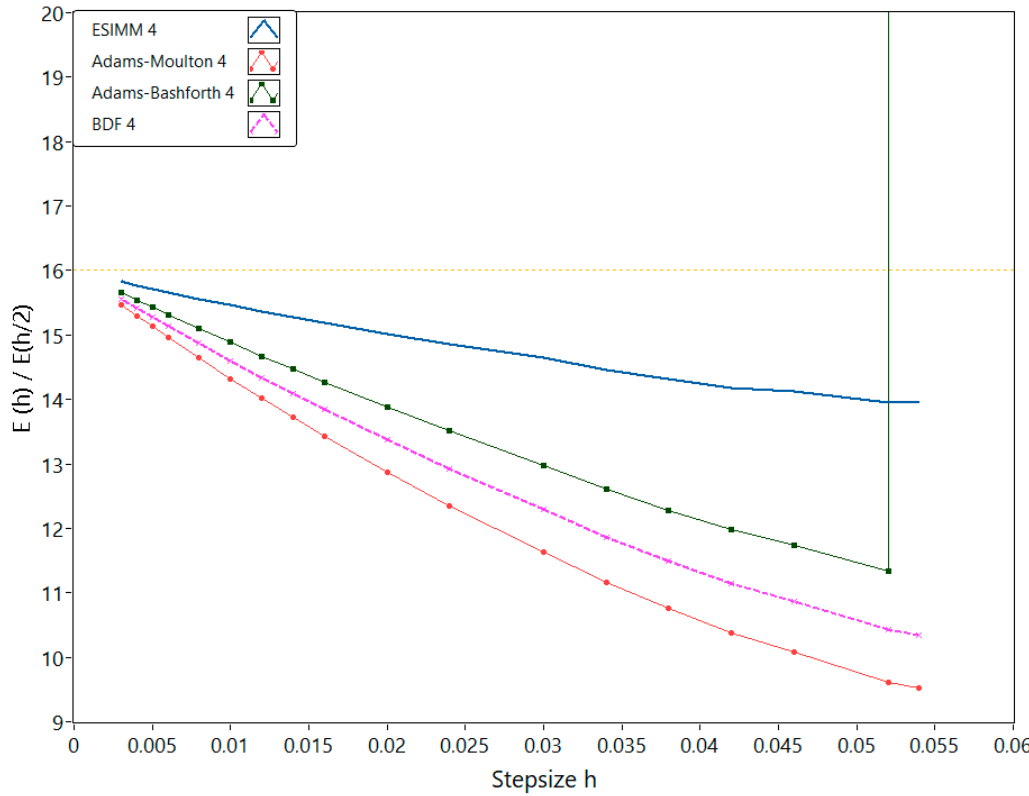
Figure 8. The order plots for investigated methods of order 4 while solving the Rossler problem. The Adams–Bashorth method experiences instability on large stepsizes.